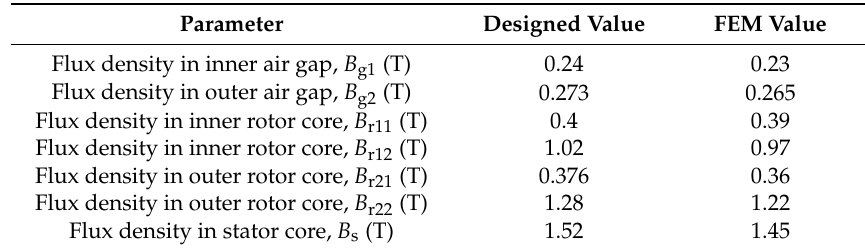
Table 2. Comparison of the designed and finite element method (FEM) measured values for the DRRF wind generator.